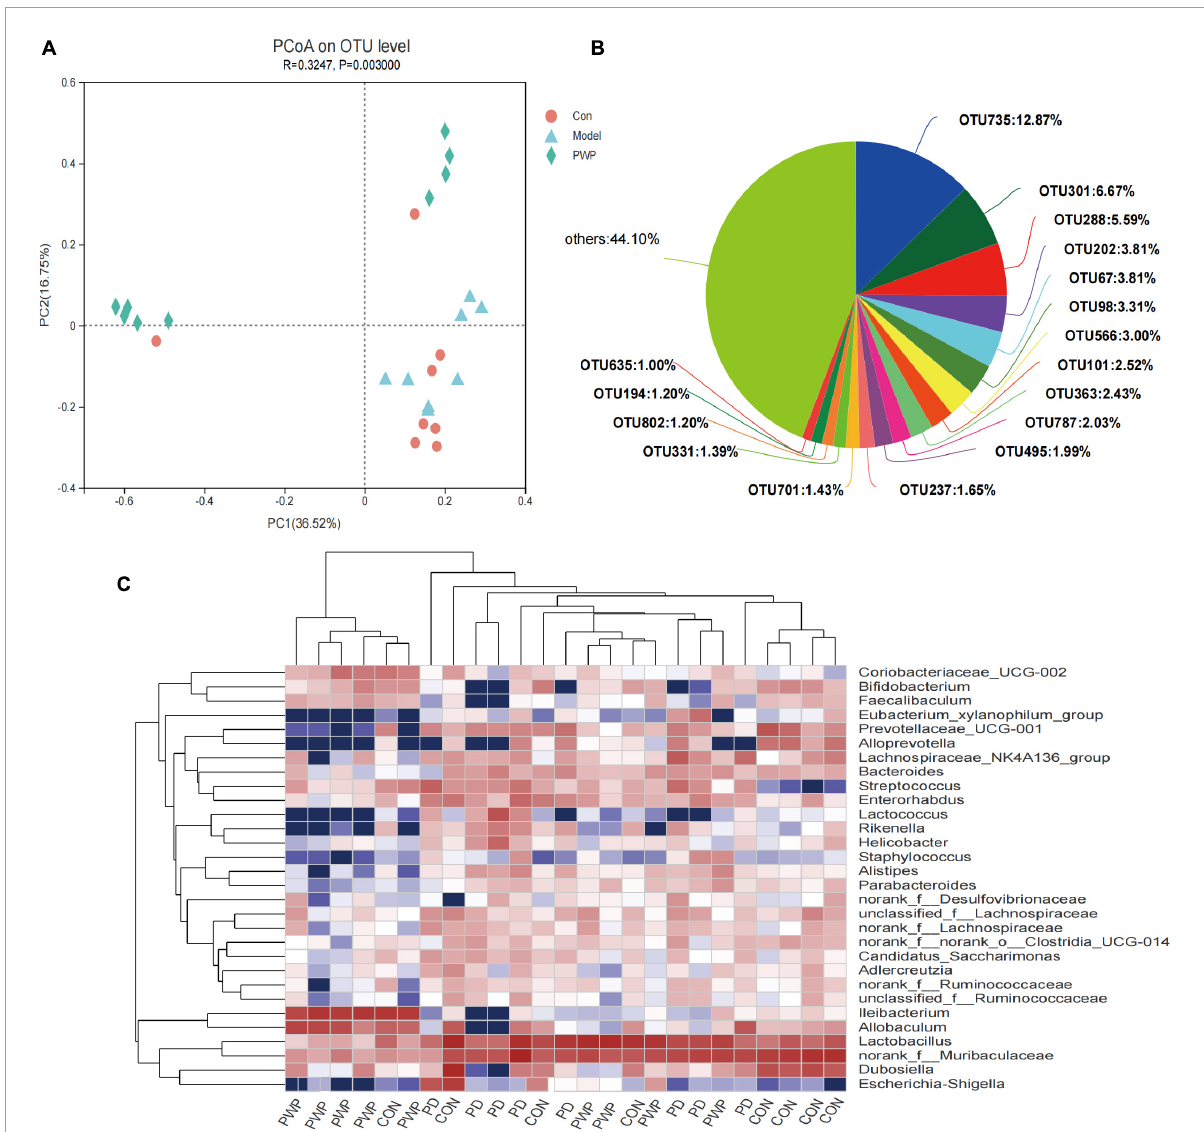
FIGURE3 The result of 16S microbiome analysis. (A) PCoA on OTU level on identified β -microbial diversity in the control, PD, and PWP groups. (B) The microbial diversity on OTU level of the control, PD, and PWP groups. (C) Community heatmap analysis by Genus.